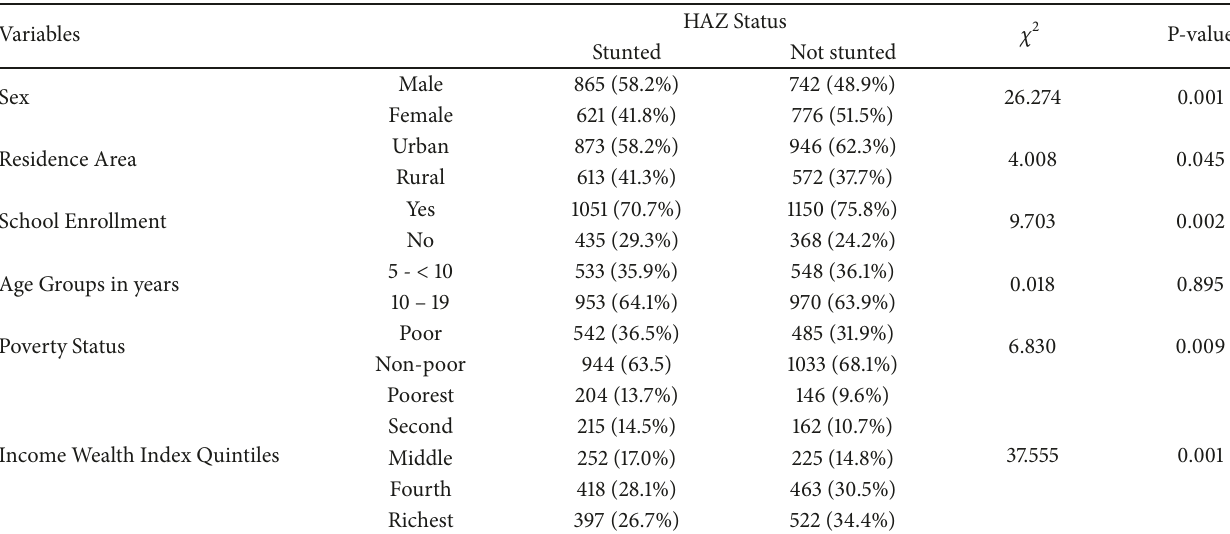
Table 3: The relationship between HAZ and other